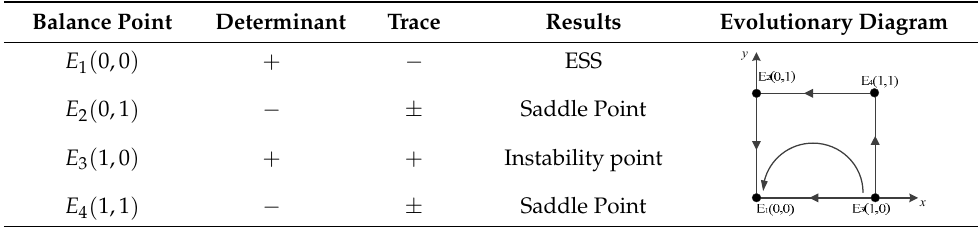
Table 6. Scenario 3 evolutionary game model steady state analysis. Balance Point Determinant Trace Results Evolutionary Diagram